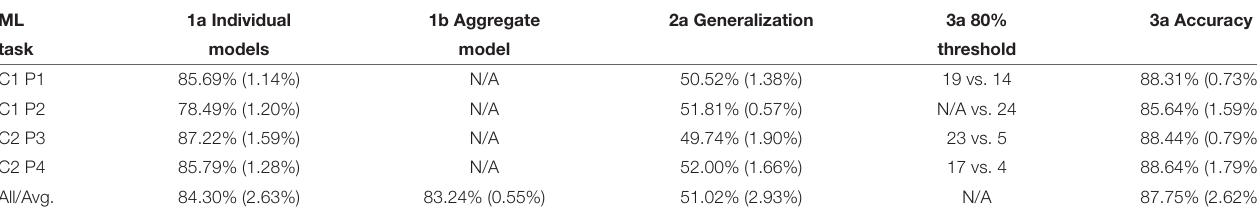
TABLE 1 | The testing results of tasks explained in the Section 4.1 using 5 train-test splits and 100 epochs.